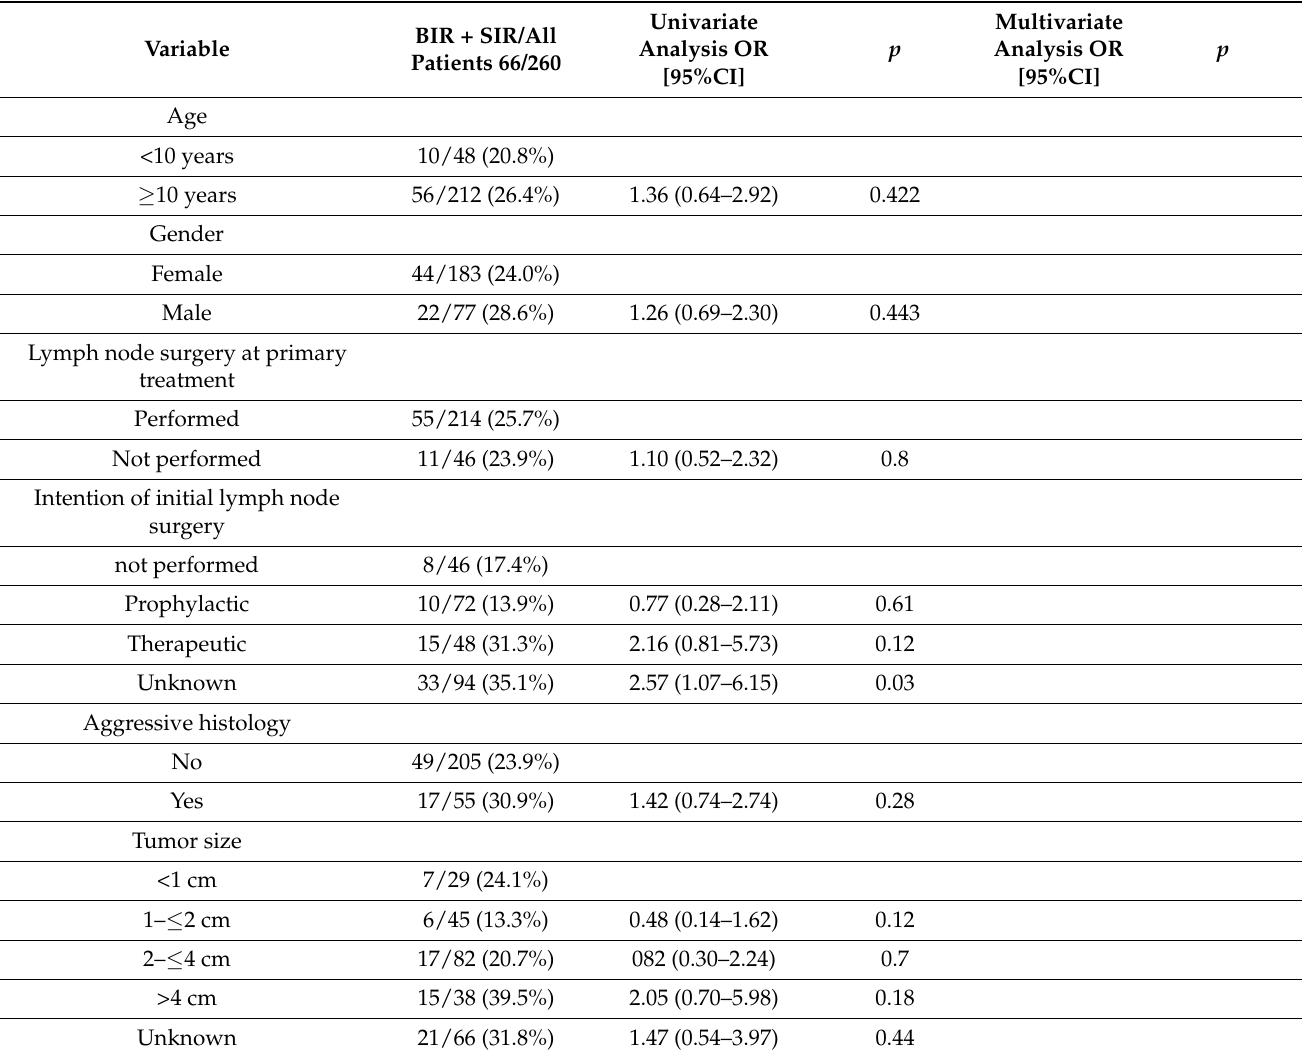
Table 5. Risk factors of persistent or recurrent disease at last